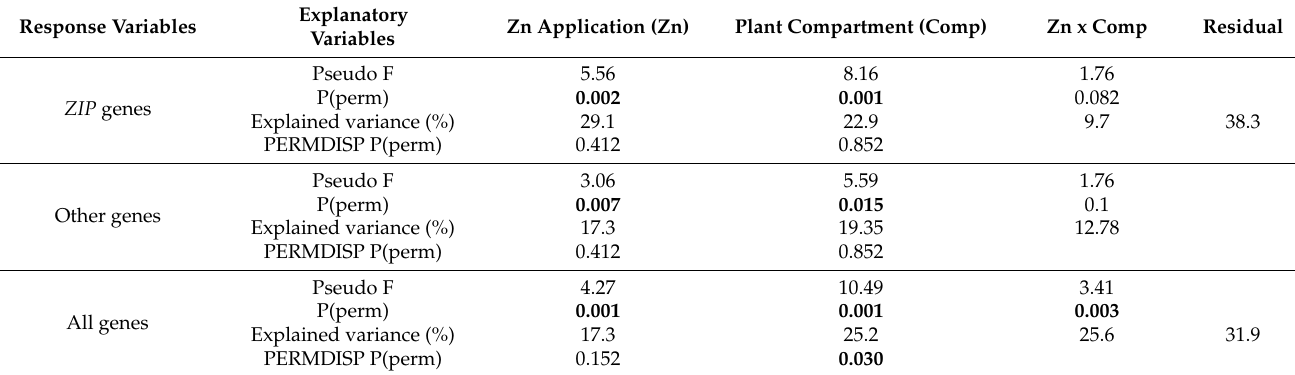
Table 1. Permutation analyses of variance (PERMANOVAs) on the effect of application of three doses of zinc (Zn) (0.1, 1, and 10 mg Zn plant − 1 ) and plant compartment (shoot and root) on the expression of seven MsZIP genes and separately on the expression of other five genes ( MsZIF1 , MsNAS1 , MsHMA4 , MsYSL1 , and MsMTP1 ). A PERMANOVA was also performed on the response of all the genes. The analysis of homogeneity of multivariate dispersion (PERMDISP) was also performed. The studied plant was alfalfa ( Medicago sativa L.). The analysis also included no-Zn addition control. Response